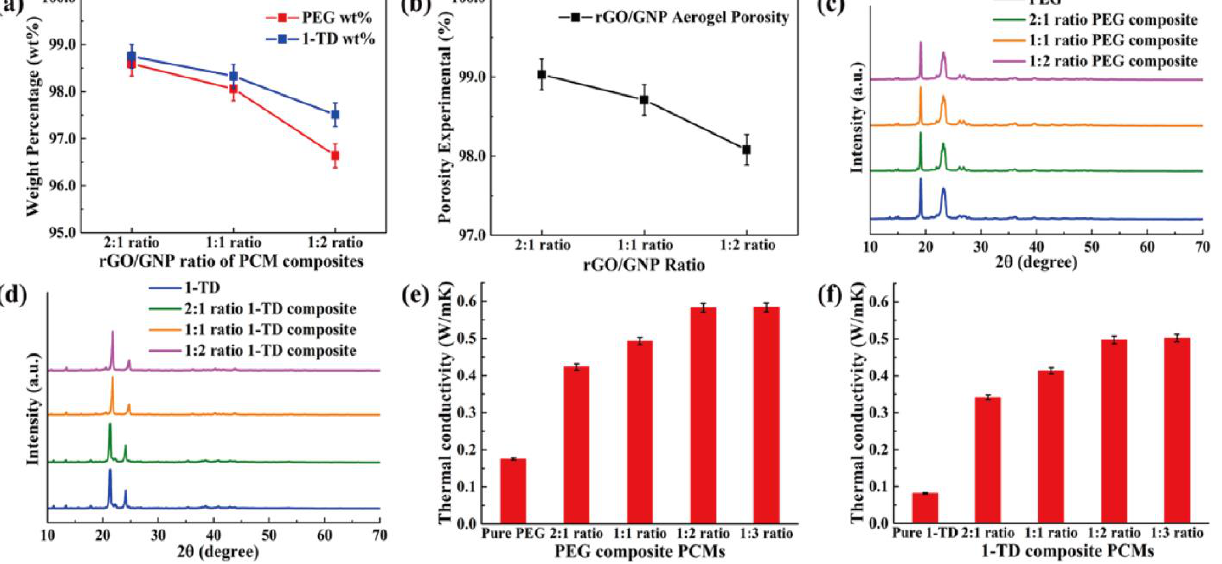
Figure 6. SEM images of ( a ) pure PEG, ( b ) 2:1 PEG composite, ( c ) 1:1 PEG composite, ( d ) 1:2 PEG composite, ( e ) pure 1- TD, ( f ) 2:1 1-TD composite, ( g ) 1:1 1-TD composite and ( h ) 1:2 1-TD composite.